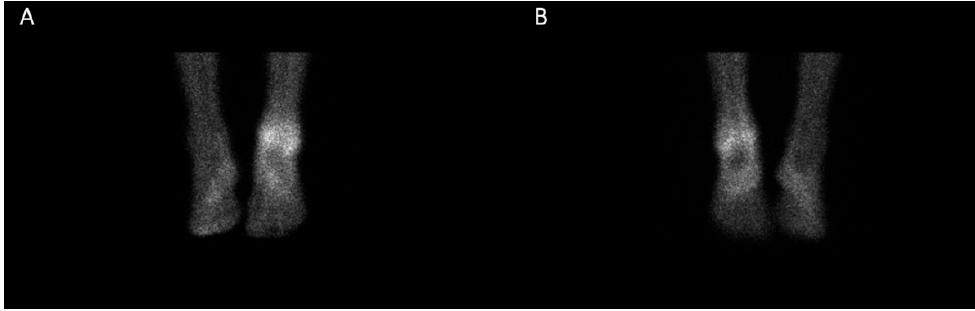
Figure 2. Blood pool imaging with technetium-99m-methyl diphosphonate ( 99m Tc-MDP) of the ankle joint before radiosynoviorthesis (RSO), demonstrating increased tracer uptake in the ankle joint (( A ) anterior view; ( B ) posterior view).